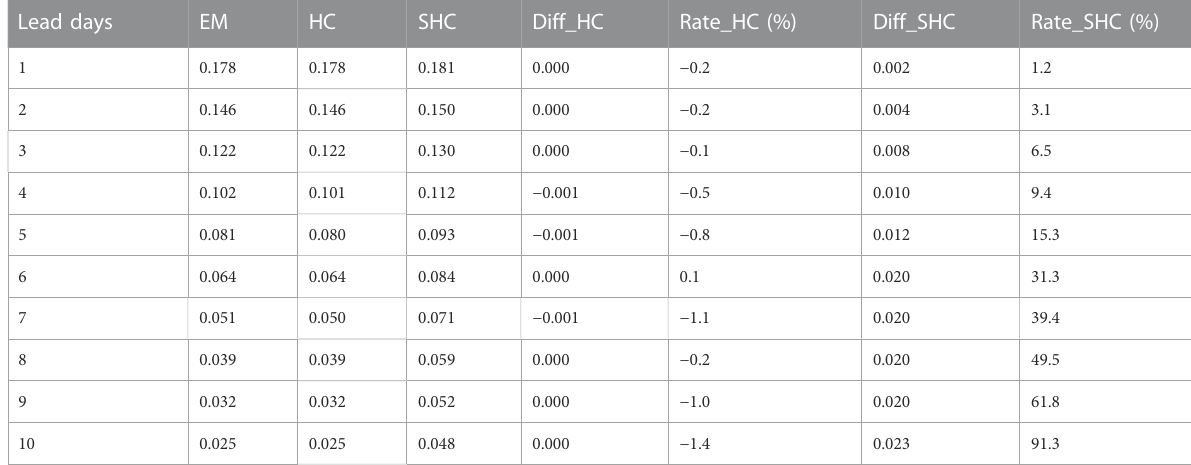
TABLE 2 Same as Table 1, but for ETS.